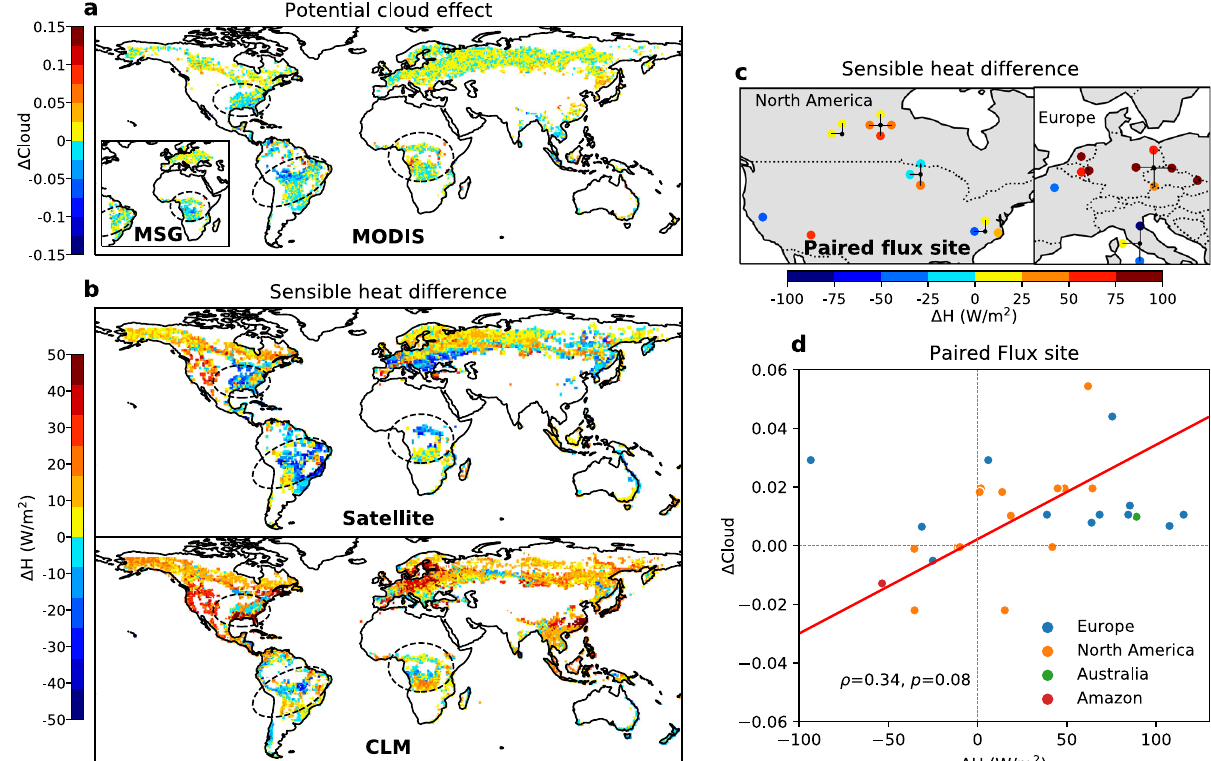
Fig. 3 The sensible heat difference between forests and non-forest and its relationship with cloud effects. a Potential effects of forests on cloud cover from MODIS and MSG data (duplicates from Fig. 1a, b). b The sensible heat differences between forests and non-forest ( Δ H) estimated from satellite data 4 , Community Land Model (CLM), and c Twenty-eight paired forest and non-forest fl ux sites (including one Amazon pair not shown on the map, see Supplementary Table 1). The three circles marked in a and b denote the locations of cloud inhibition which correspond to the negative Δ H in Amazon, Central Africa, and Southeast US. The connection lines with a dot in panel c indicate the location of fl ux tower clusters where multiple fl ux pairs are close in distance. d The relationship between sensible heat ( Δ H) and cloud differences between forest and non-forest ( Δ Cloud) at paired fl ux towers. The cloud effects at paired fl ux site locations are extracted from Δ Cloud aggregated to 1° based on MODIS data. The line is fi tted by geometric mean regression 80 . The Spearman ’ s correlation coef fi cient ( ρ ), which is a nonparametric measure of rank correlation, is calculated by the spearmanr function of scipy.stats module in Python with its p value ( p ) determined by a two-tail t